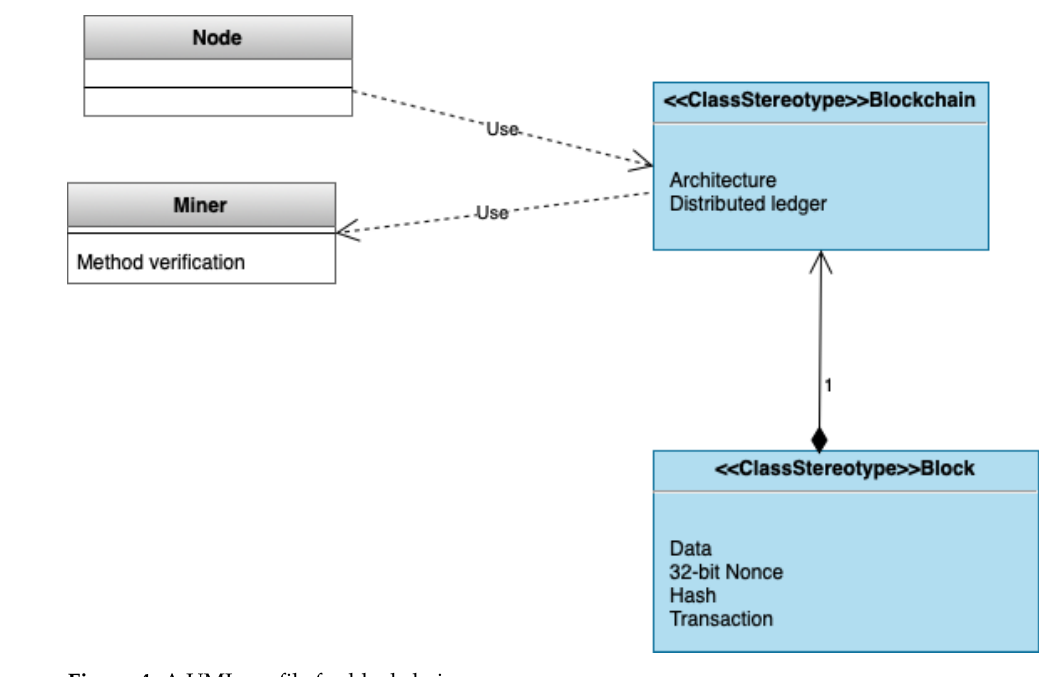
Figure 4. A UML profile for